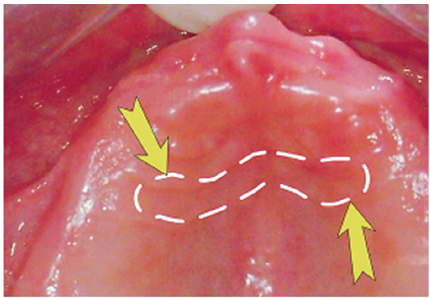
Table 1: Distributions of dentures according to